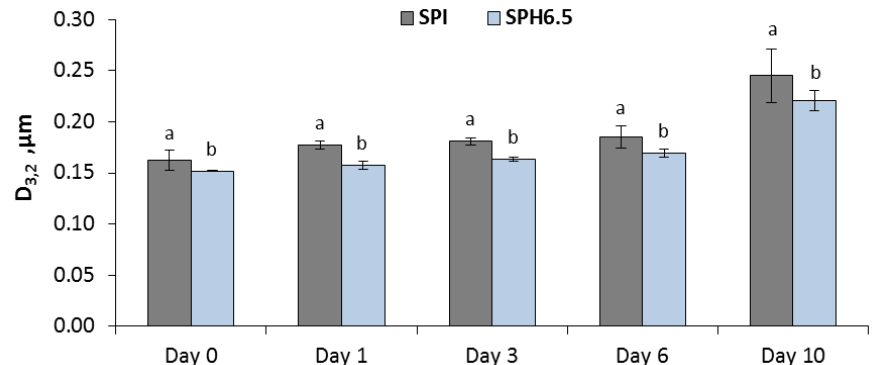
Figure 4. Droplet size of emulsions stabilized with a soy protein isolate (SPI) and soy protein hydrolysate (SPHT6.5) during storage at 20 °C. * Different letters represent significant differences between SPI and SPH6.5 ( p < 0.05).